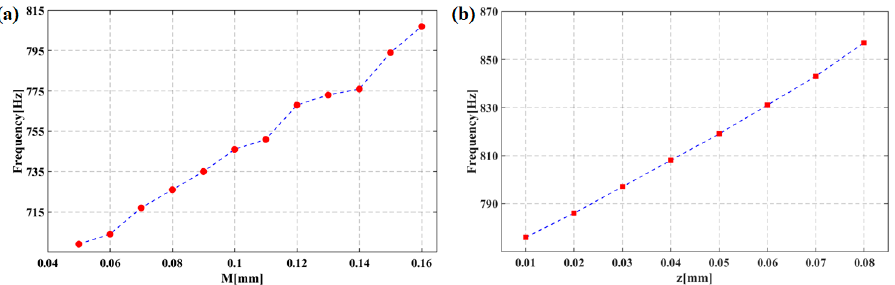
Figure 11. ( a ) Effects of the concave depth M on the natural frequency. ( b ) Effects of the hollow diameter z on the natural frequency.